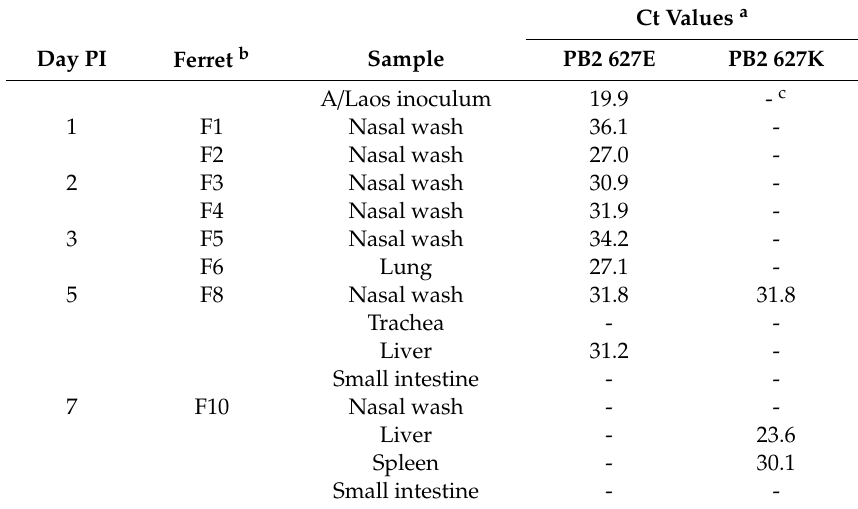
Table 4. A / Laos PB2 627 single nucleotide polymorphism (SNP) analysis following infection of ferrets.